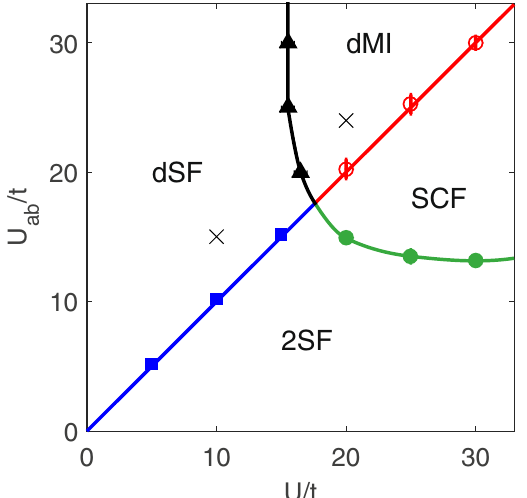
Figure 1. Ground-state phase diagram of twin bosonic species at total filling n = 1, from ref. 29. Crosses indicate the parameters used here for simulations. The dSF (dMI) phase represents two spatially separated superfluids (Mott-Insulators). 2SF describes two mixed superfluids, and SCF is a global Mott-insulator phase where mobility is allowed as a superflow in the particle-hole